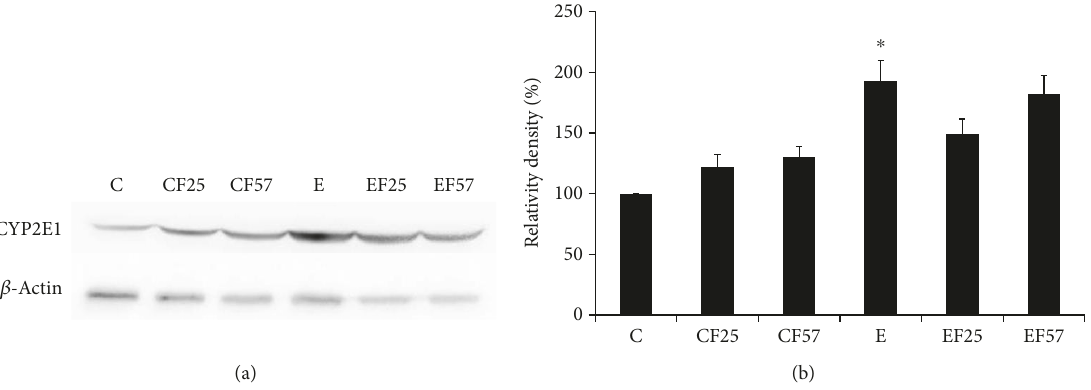
Figure 2: Hepatic CYP2E1 protein expressions in each group. Values are expressed as the mean ± SEM. C: control group; CF25: control diet with fi sh oil substituted for 25% of olive oil; CF57: control diet with fi sh oil substituted for 57% of olive oil; E: ethanol group; EF25: alcohol-containing diet with fi sh oil substituted for 25% of olive oil; EF57: alcohol-containing diet with fi sh oil substituted for 57% of olive oil. Bars with ∗ signi fi cantly di ff er between groups C and E at the p < 0 05 level according to Student ’ s t